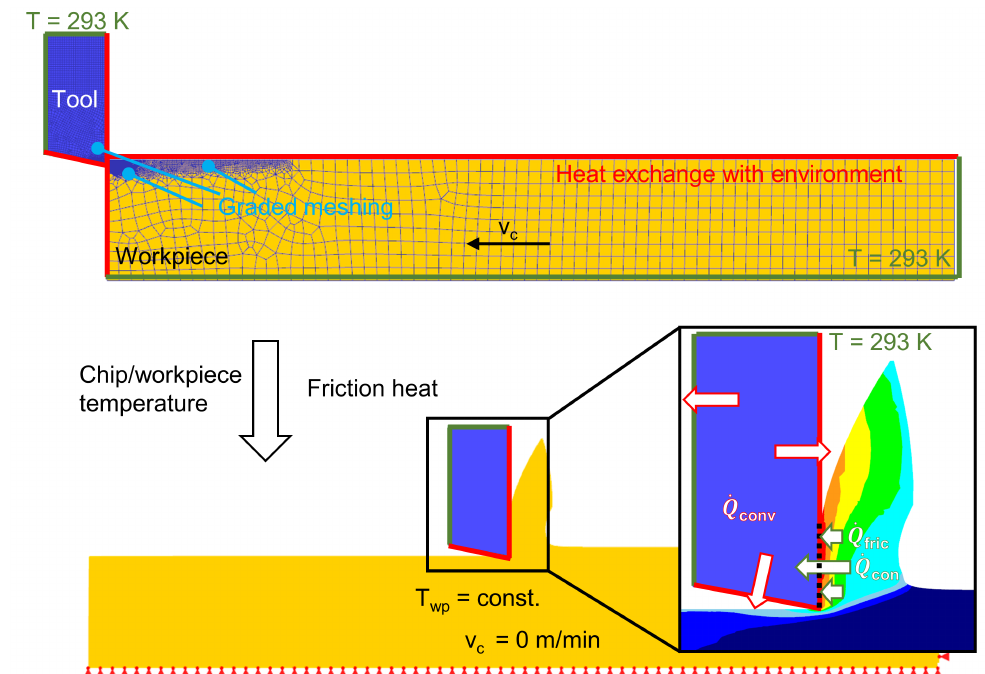
Figure 9. Schematic illustration of the boundary conditions for the thermal simulation in FEM for AISI 1045.